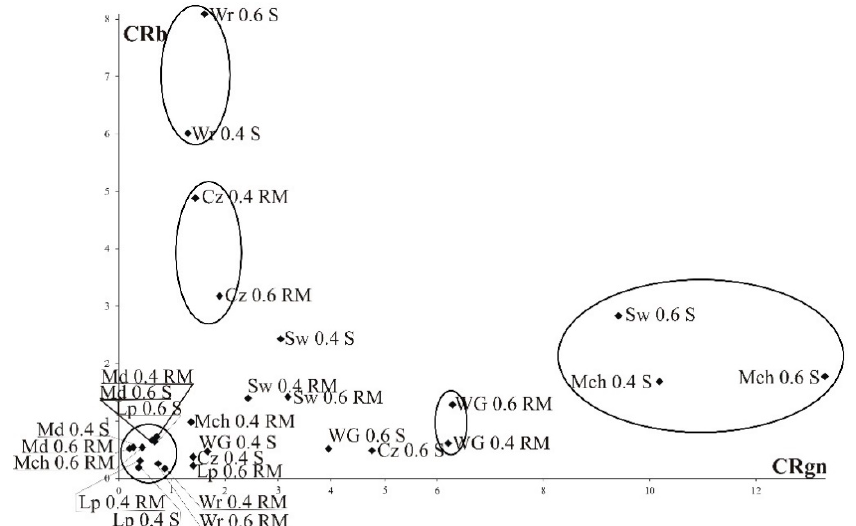
Figure 8. The distribution of sites × winter wheat proportion in the mixture × bentgrass biotypes for the competitive ratio indices calculated for the relative number of grains (CRgn) and relative biomass of plant (CRb) in 2018–2019. Legend: The sites of experiments: Lp—Lipnik, Mch—Mochełek, Cz—Czesławice, Sw—Swojczyce, Wr—Wrocław, WG—Winna G ó ra, Md—Mydlniki; 0.4 and 0.6—40% and 60% proportion of winter wheat in the mixture; RM—bentgrass biotype with a multiple resistance; S—susceptible biotype.